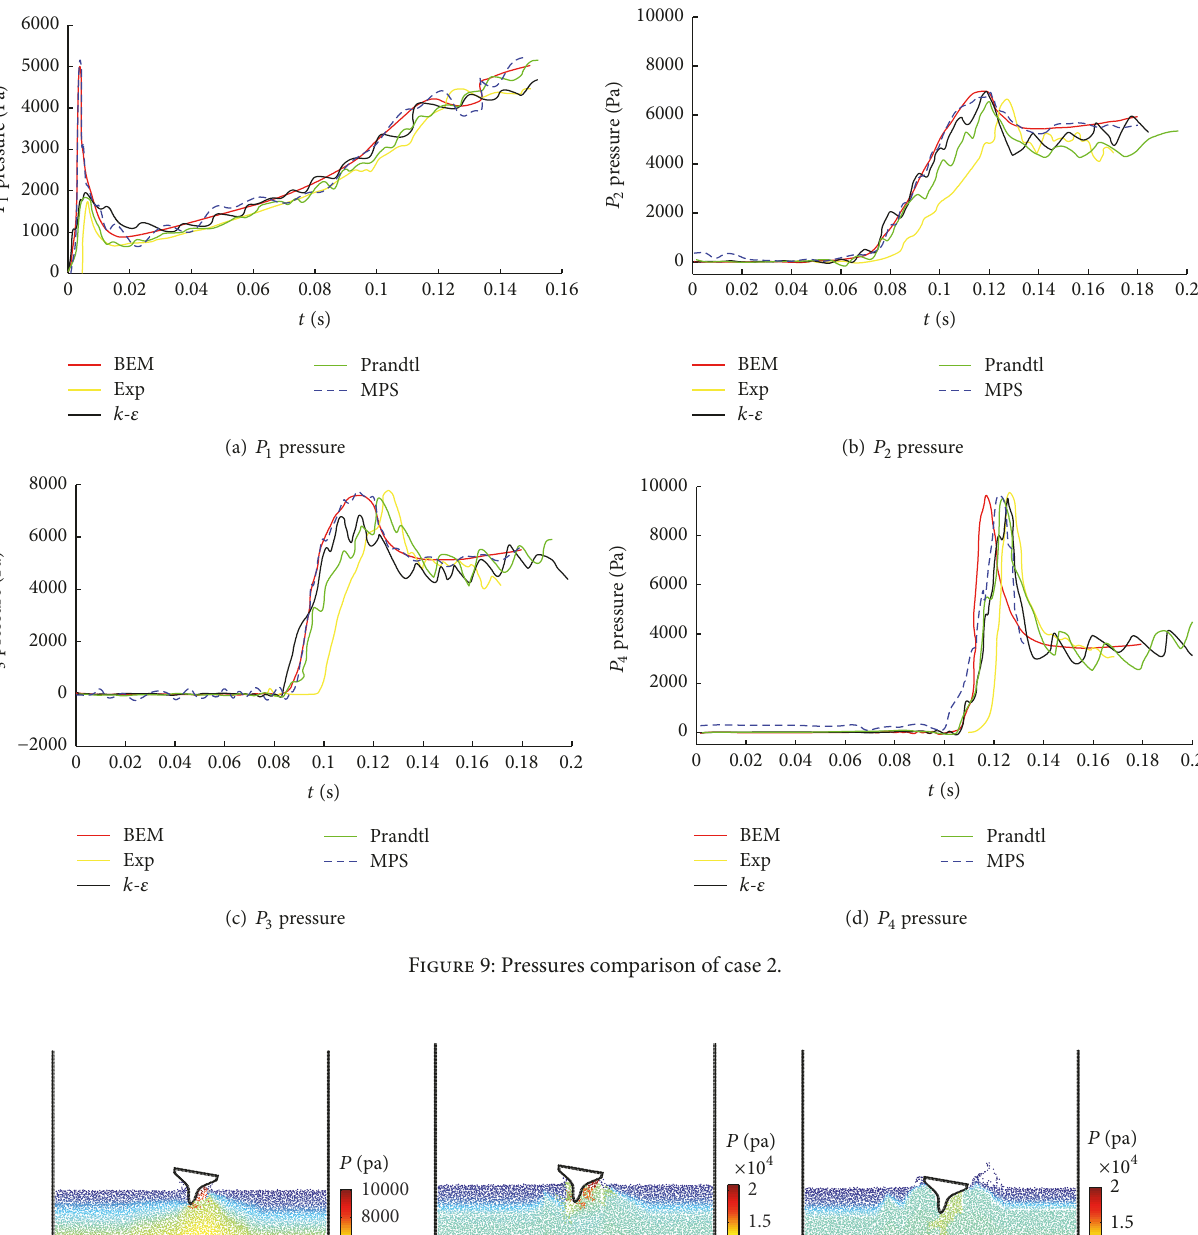
gives a better numerical prediction of the pressures, which is close to the experiment